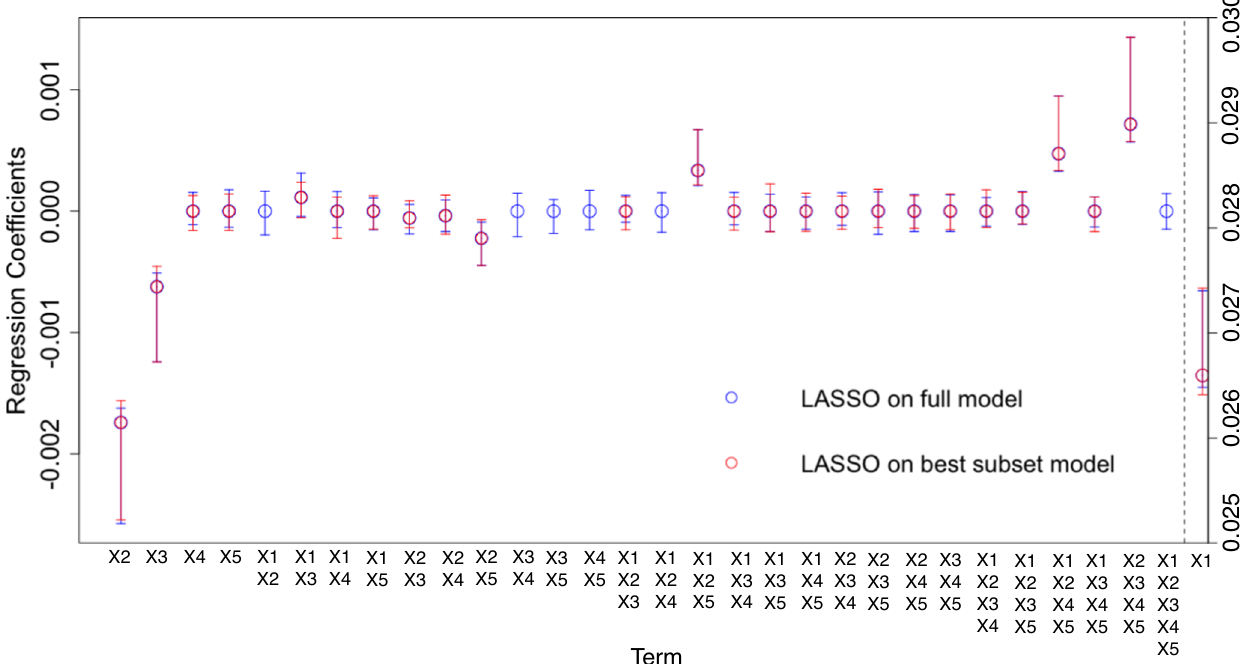
Fig. 6 90% con fi dence intervals of the regularized regression coef fi cients from applying LASSO to the full model (marked in blue) and the best subset model (marked in red) respectively. The X-axis contains the labels for the model terms, where P A , λ , μ , γ , − d γ /d T , are denoted by X 1 , X 2 , X 3 , X 4 , X 5 respectively. The plot illustrates the regression coef fi cients on a dual Y-axis scale, with the Y-axis on the right displaying the range of values for the regression coef fi cient of X 1 , and the Y-axis on the left representing the range of values for the regression coef fi cients of all other variables. The regression coef fi cient for X 1 exhibits a signi fi cantly different magnitude from other variables. A dotted line demarcates the boundary between the two Y-axes, with values on the left corresponding to the left Y-axis, and values on the right corresponding to the right